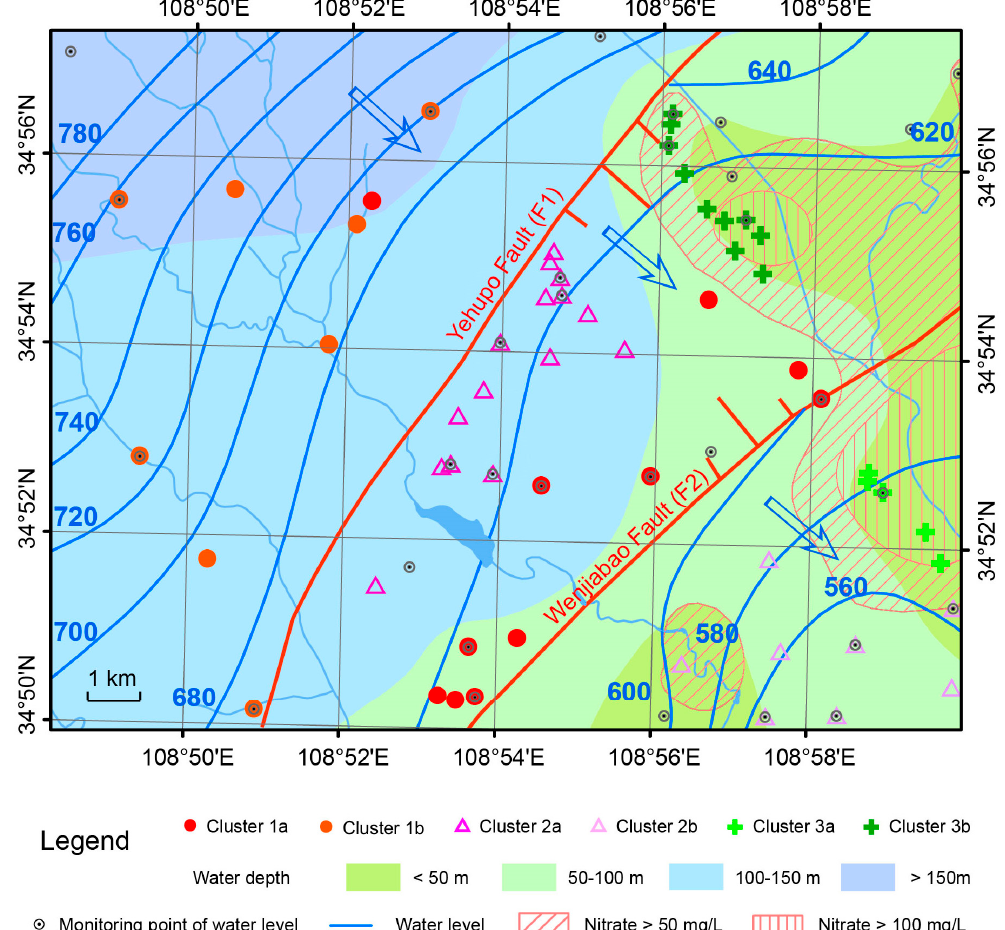
Figure 3. Map showing the hydraulic head pattern, groundwater flow direction, groundwater depth, location of monitoring wells, areas where nitrate exceeds the World Health Organization (WHO) guideline value, and distribution of all sub-clusters.